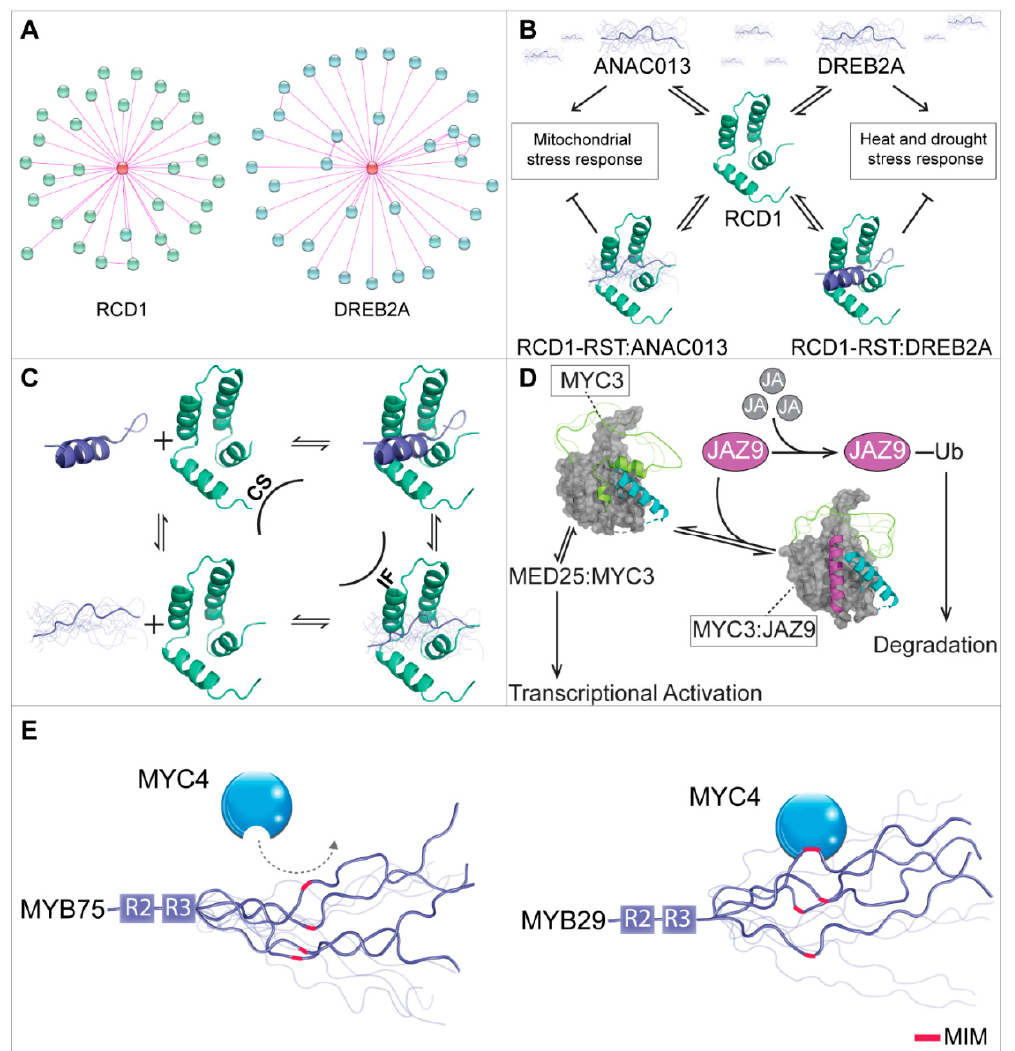
Figure 2. TF-ID in regulatory interactions ( A ) ID-based interactomes and mechanisms of interactions. ( A ) RCD1 and DREB2A interactomes curated from the STRING database, with medium confidence score (0.400) and including only experimental interactions. ( B ) Model of RCD1:TF interactions involving structural heterogeneity in the complexes. Several TFs, including DREB2A and ANAC013, may compete for binding to RCD1. Some TFs, e.g., DREB2A, undergo coupled folding and binding upon association with RCD1-RST, whereas other, e.g., ANAC013, may keep disorder in the complexes. RCD1 negatively regulates its TF interaction partners. The structure of the RCD1-RST domain (PDB 5OAO) is visualized using PyMOL. ( C ) Mechanisms of coupled folding and binding: conformational selection (CS) and induced fit (IF). In CS, a conformation from the TF ensemble is selected for binding by the partner protein. In IF, the TF recognizes its partner in a disordered state that folds after binding to the partner protein. ( D ) MYC3 in free (PDB 4RRU) and JAZ9-bound (PDB 4YWC) states. The Jas-motif of JAZ9 (purple) binds the N-terminal domain (grey) of MYC3, displacing the α 1 helix (green) and rearranging the JID helix (cyan) of MYC3. The MYC3:JAZ9 complex cannot bind MED25 and is therefore not transcriptionally active. Upon release of JA hormone, JAZ9 is released from MYC3 and degraded through the ubiquitin-proteasome pathway enabling MED25:MYC3 complex formation. ( E ) The MYB–MIM:bHLH interaction is context dependent. The MIM SLiM, present in sub-group 12 MYB TFs as MYB29, only interacts with the bHLH TF MYC4 when present in its natural IDR context and not when inserted in the IDR context of e.g., MYB75. RCD1 uses the RCD1, SRO, and TAF4 (RST) domain for its many interactions with TFs [47,48,108,140].